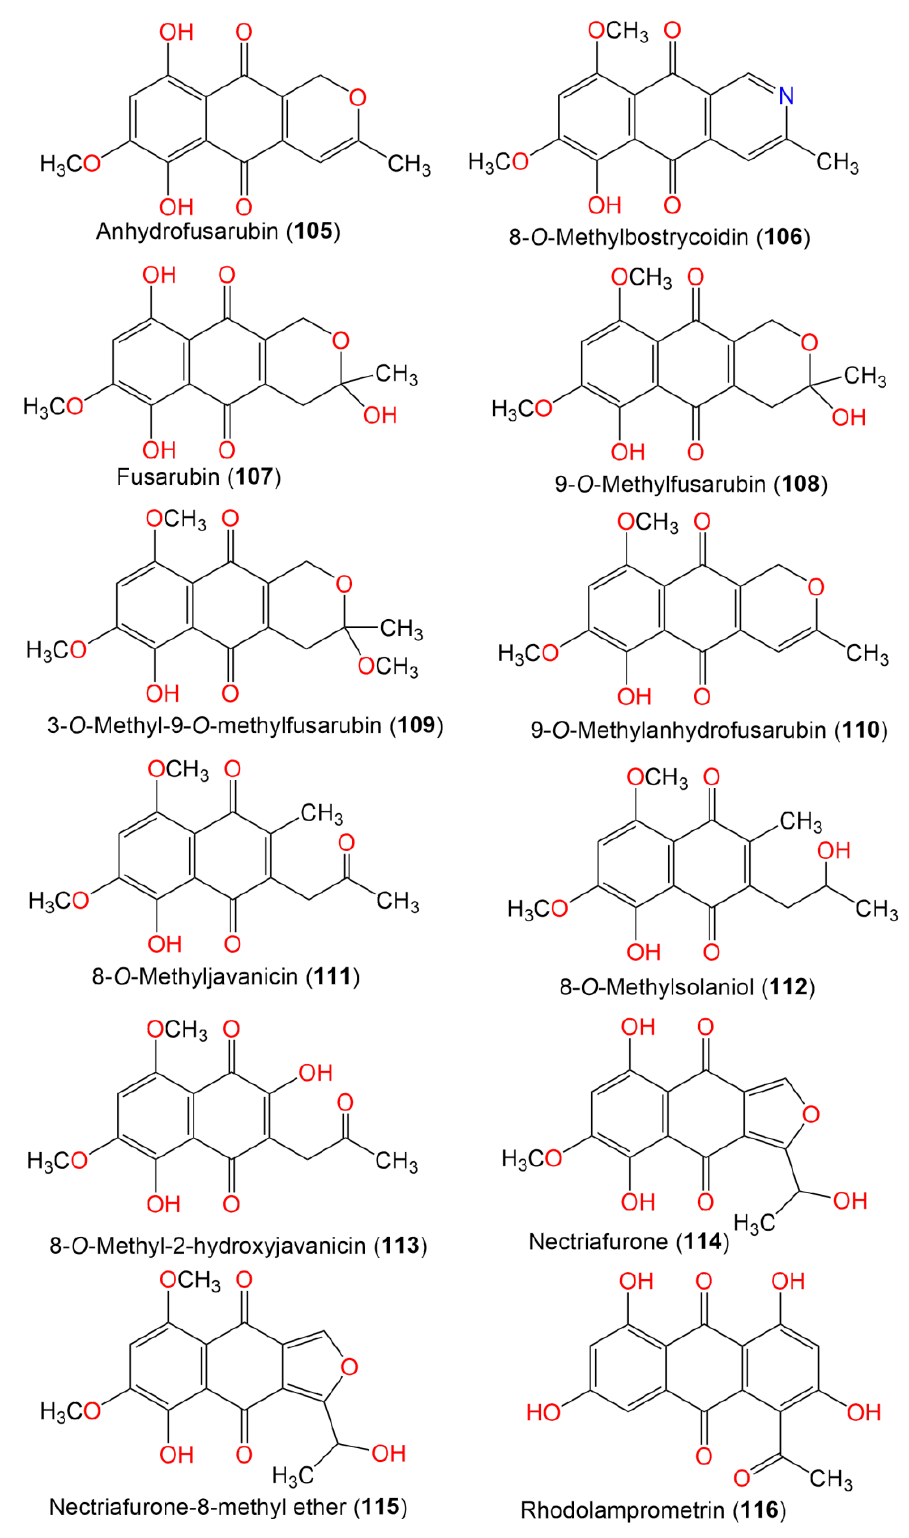
Figure 12. Structures of naphthoquinone ( 105 – 115 ) and anthraquinone ( 116 ) derivatives isolated from F. oxysporum